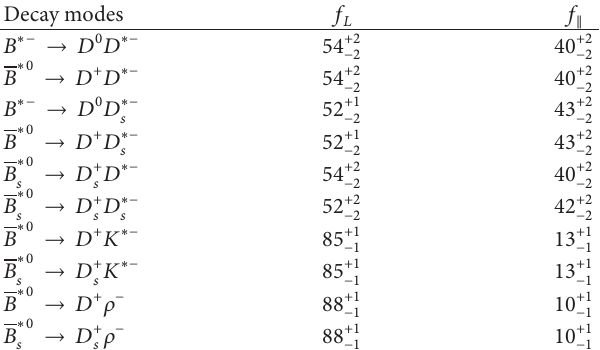
Table 2: The CP-averaged branching fractions of nonleptonic 𝐵 ∗ weak decays. Decay modes Class